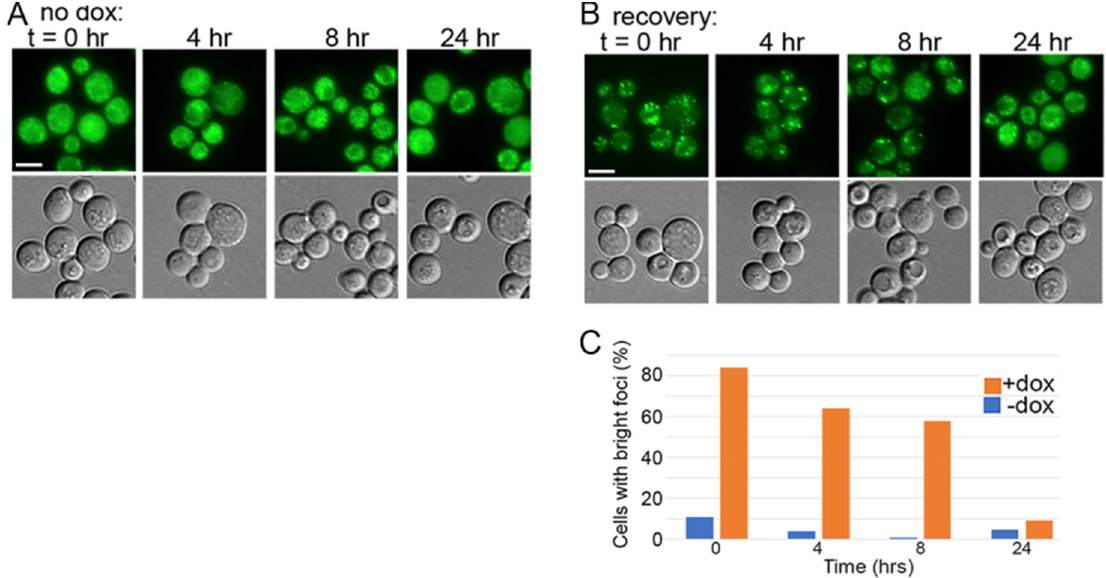
Figure 5. NGMC is recovered from large aggregates by restoring Sis1. ( A ) Cells of strain 2140 grown without doxycycline for 28 h and then monitored for fluorescence at the times indicated above. ( B ) Parallel cultures grown with doxycycline for 28 h and then monitored similarly after switching to medium without doxycycline. ( C ) Quantitation of percent of cells in population in panel B, that have large bright aggregates ( n = 100–200). Scale bars = 5 mm; all images in each panel are at same